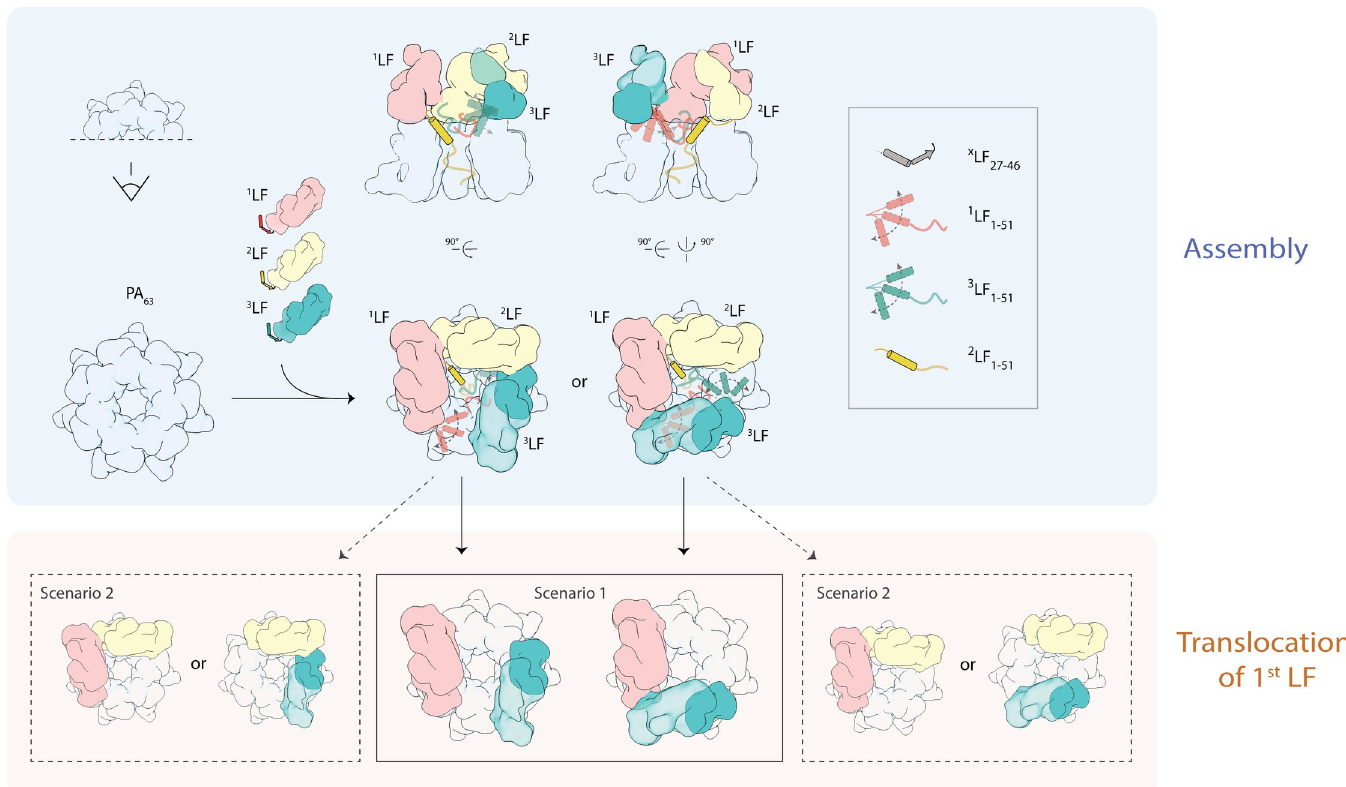
Fig 6. Model for PA 7 LF 3 assembly and translocation. After anthrax-receptor-mediated PA 7 formation on the surface of the host cell, three LFs bind to PA 7 to assemble into the fully loaded anthrax lethal toxin. As a consequence of the symmetry mismatch between PA 7 and three LFs, the third LF can attach to two different PA sites, resulting in two distinct PA 7 LF 3 complexes. In both arrangements, the three LFs form a continuous chain of head-to-tail interactions. One LF, namely 2 LF, undergoes a conformational change from the “closed” state as observed in the unbound LF structure to an “open” state, which is characterized by an interaction of its N-terminal α - helix with the α -clamp region of PA. The other two LFs, 1 LF and 3 LF, adopt an “intermediate” state, i.e. being neither in an “open” nor “closed” conformation. Two different scenarios for the translocation of the 1 st LF after transitioning into the pore state are conceivable: In scenario 1, 2 LF, being in the “open” state is translocated first, whereas either 1 LF or 3 LF are translocated first in scenario